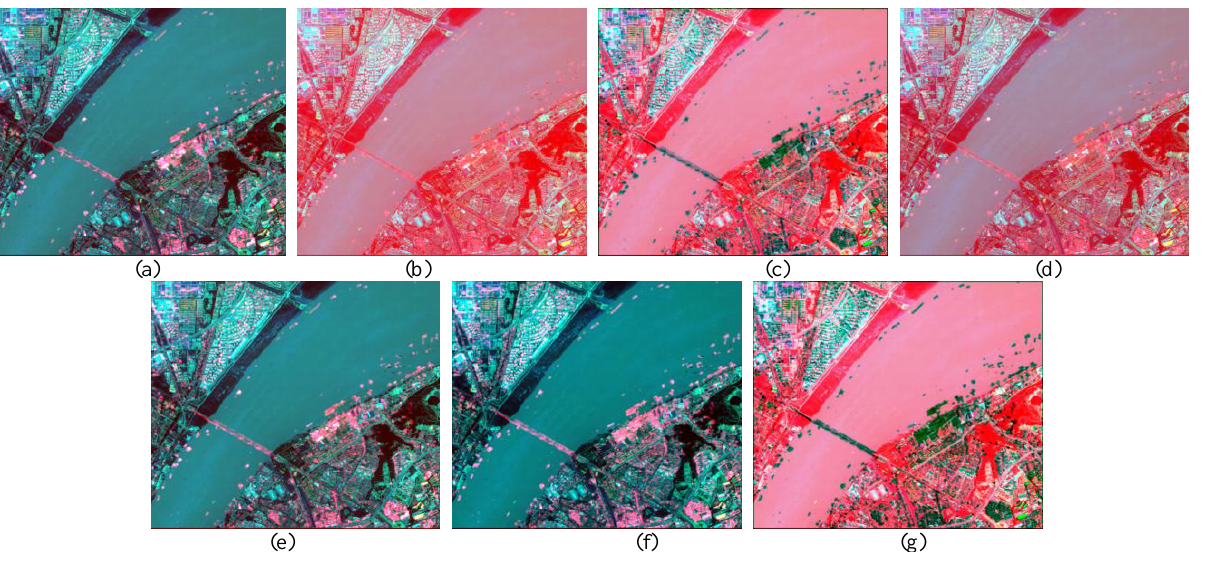
Figure 3. (a) ~ (g) are fusion results with different textural measures by PCA. (The corresponding textural measures sequence is Mean, Variance, Homogeneity, Contrast, Dissimilarity, Entropy, and Second